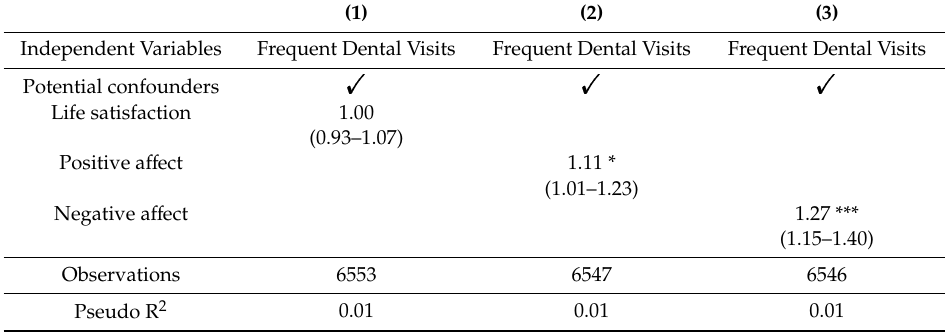
Table 3. Determinants of frequent dental visits (0 = Non-frequent dental visits; 1 = Frequent dental visits; cut-o ff at the highest quartile). Results of multiple logistic regressions 1